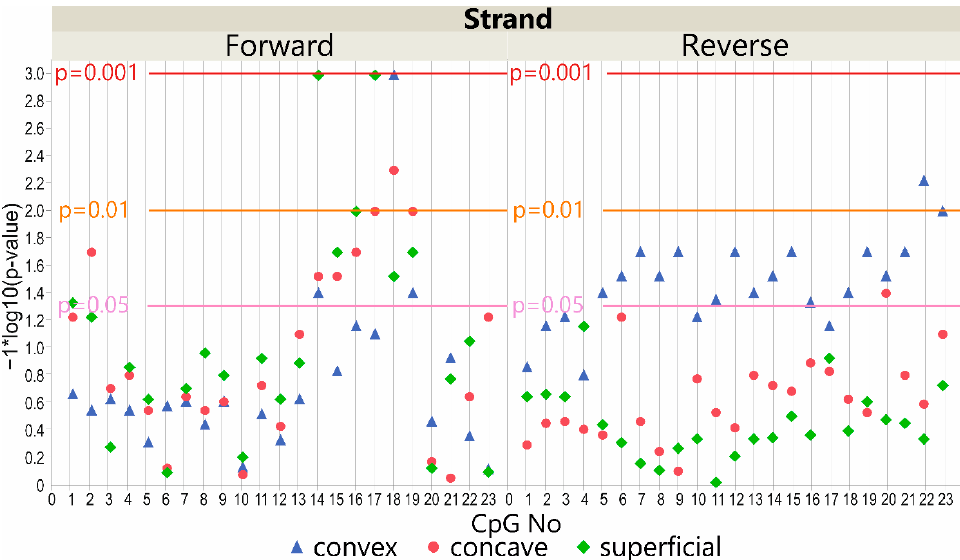
Figure 3. Scatter plot of − log10 p -values showing the difference between patients with major curve angle ≤ 70° and >70° in methylation level at LBX1 DNA forward strand (left) and DNA reverse strand (right) promoter CpG sites in deep convex (blue triangles), deep concave (red triangles), and superficial (green diamonds) muscles. Reference horizontal lines represent the p -values.